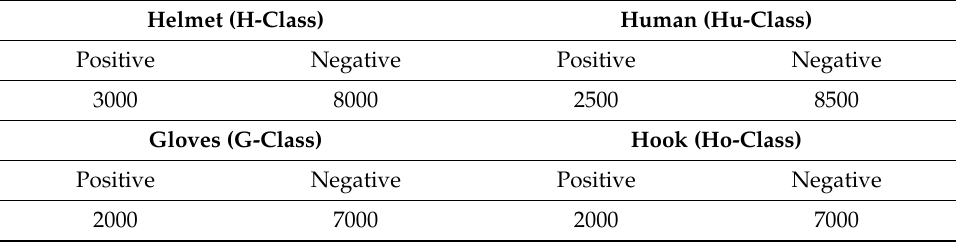
Table 2. Number of training images for each Table 1. Haar-cascade training technical data.